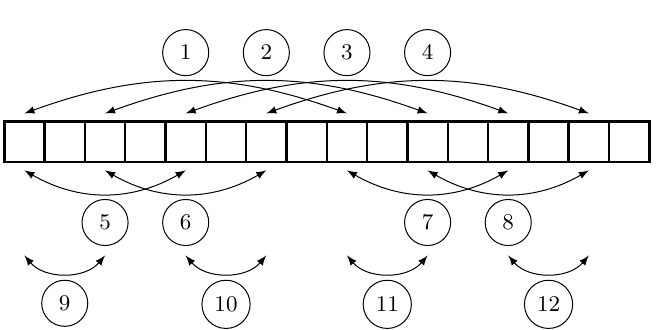
Figure 2: The order of butterfly operations for an NTT with three merged